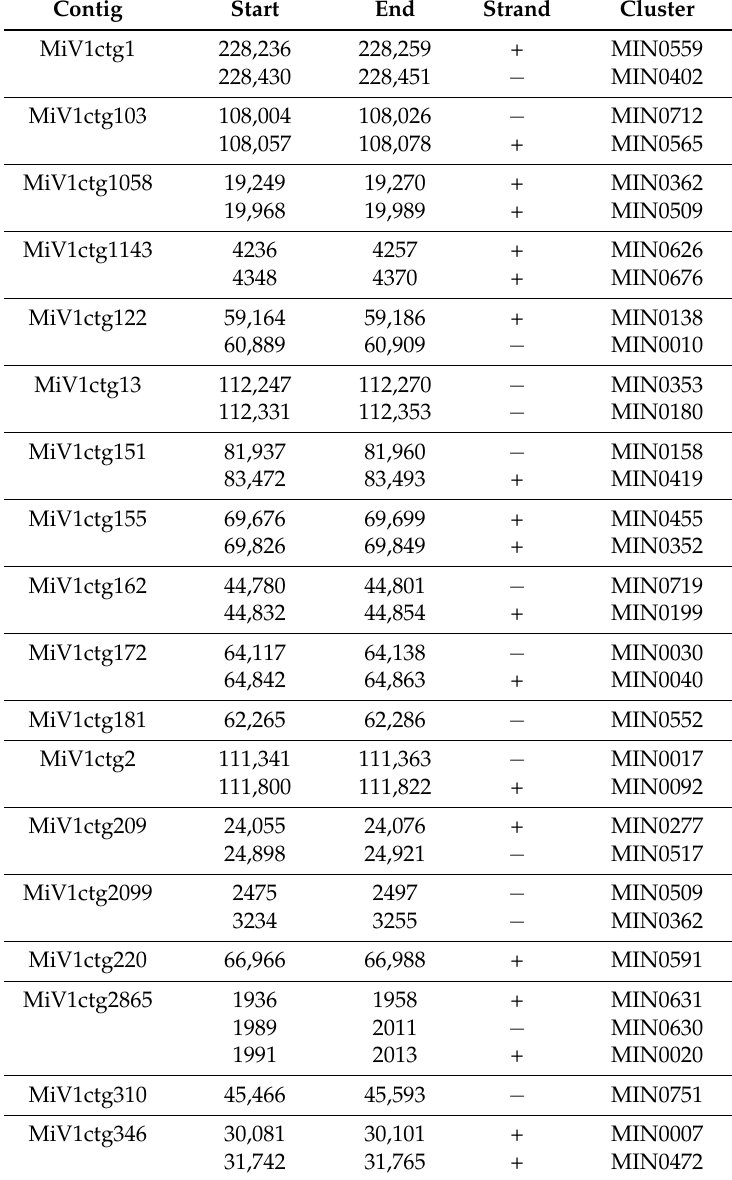
Table 7. Novel miRNA clusters of M. incognita found in our